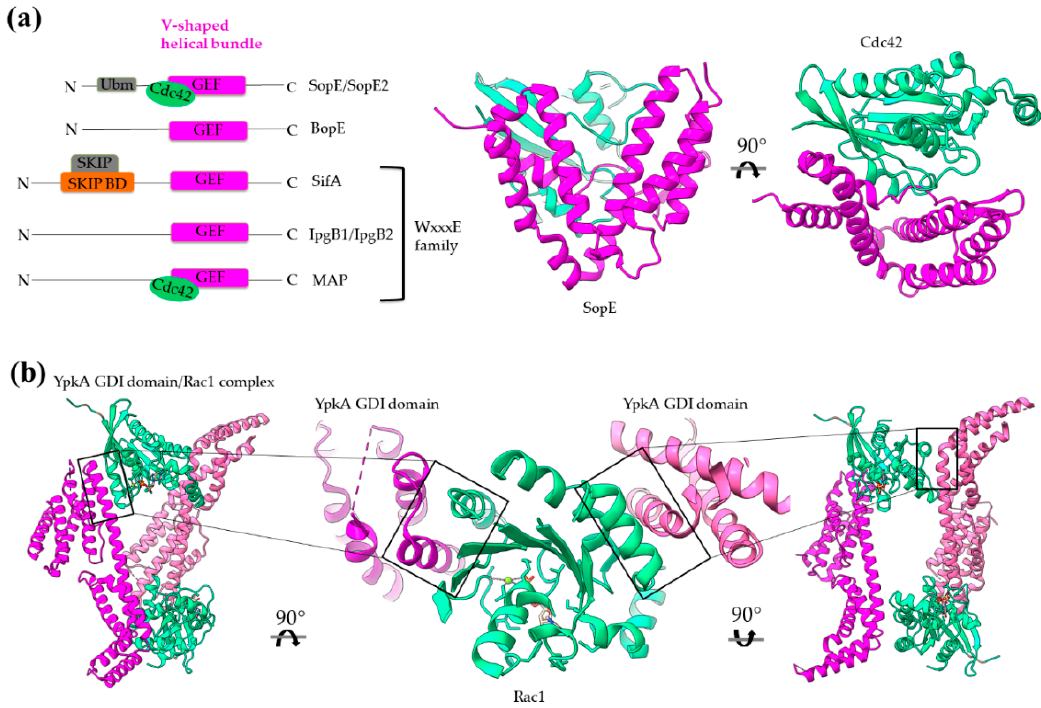
Figure 9. Bacterial structures with GEF ( a ) and GDI ( b ) activities. ( a ) Left: Schematic comparison of the domain architecture of bacterial GEFs. SKIP stands for the host SifA kinesin interacting protein. Right: The GEF domain is a V-shaped helical bundle as it is representatively illustrated by the SopE structure (magenta). The structure of SopE is shown in complex with the host Cdc42 (green, PDB id 1GZS). ( b )The YopO/YpkA dimer structure (magenta/pink) in complex with Rac1 (green, PDB id 2H7V).